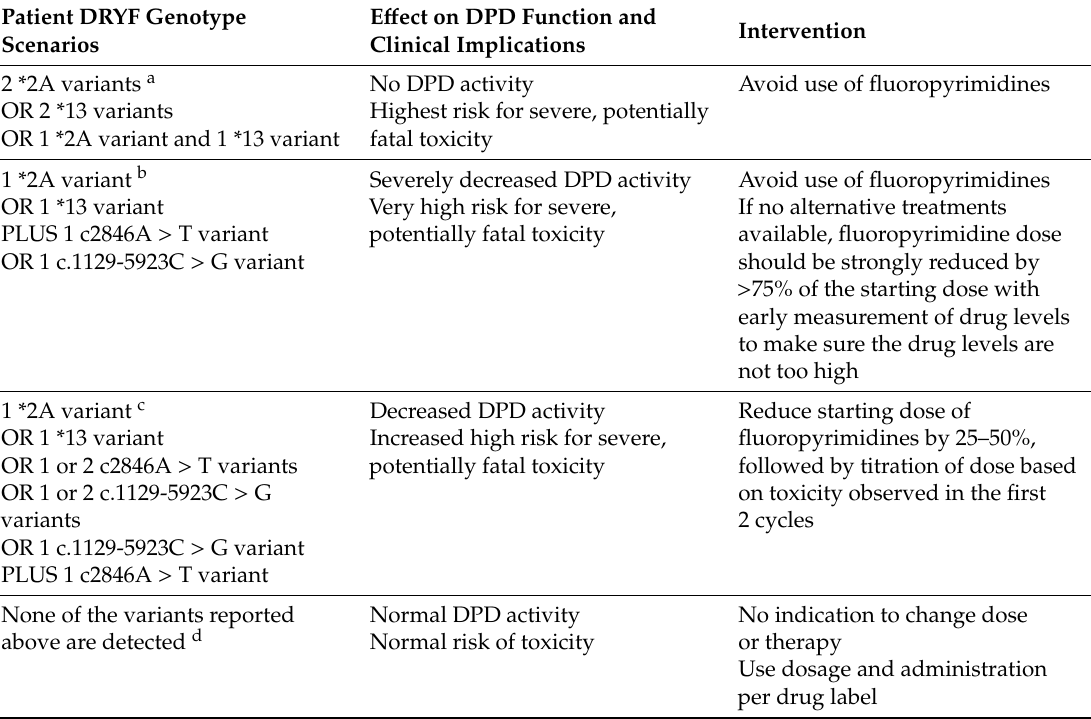
Table 1. Clinical recommendations for patients treated with fluoropyrimidines based on DPYD genetic testing